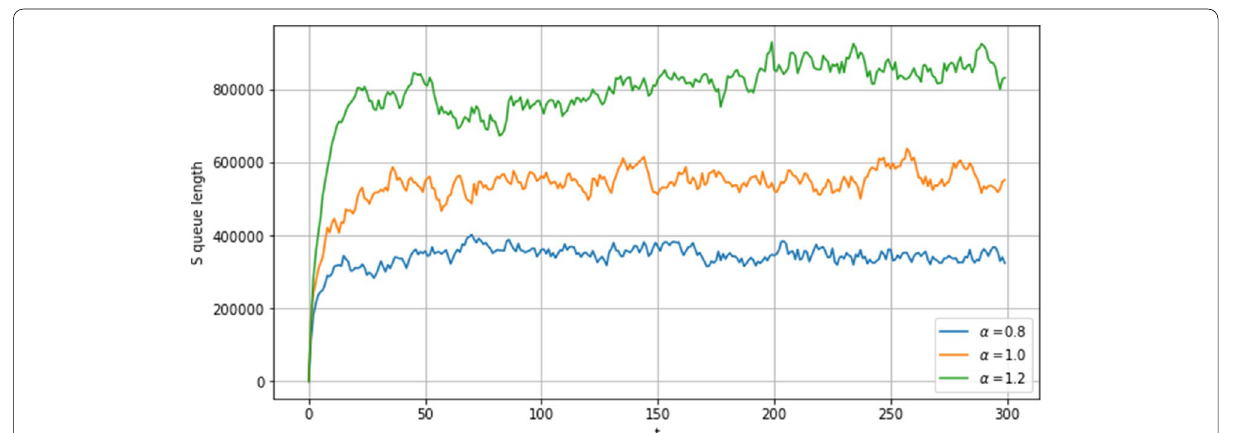
Fig. 4 Queue length of IoT devices with different task arrival